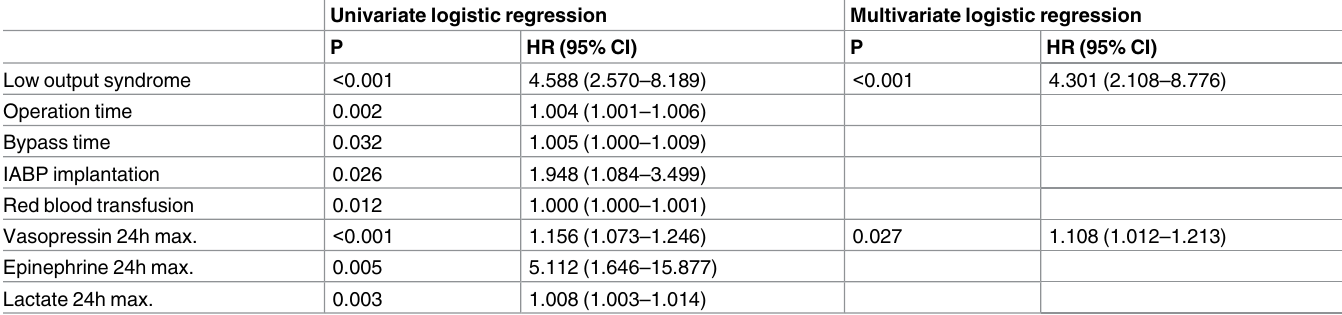
Table 5. Univariate and Multivariate logistic Cox Regression.